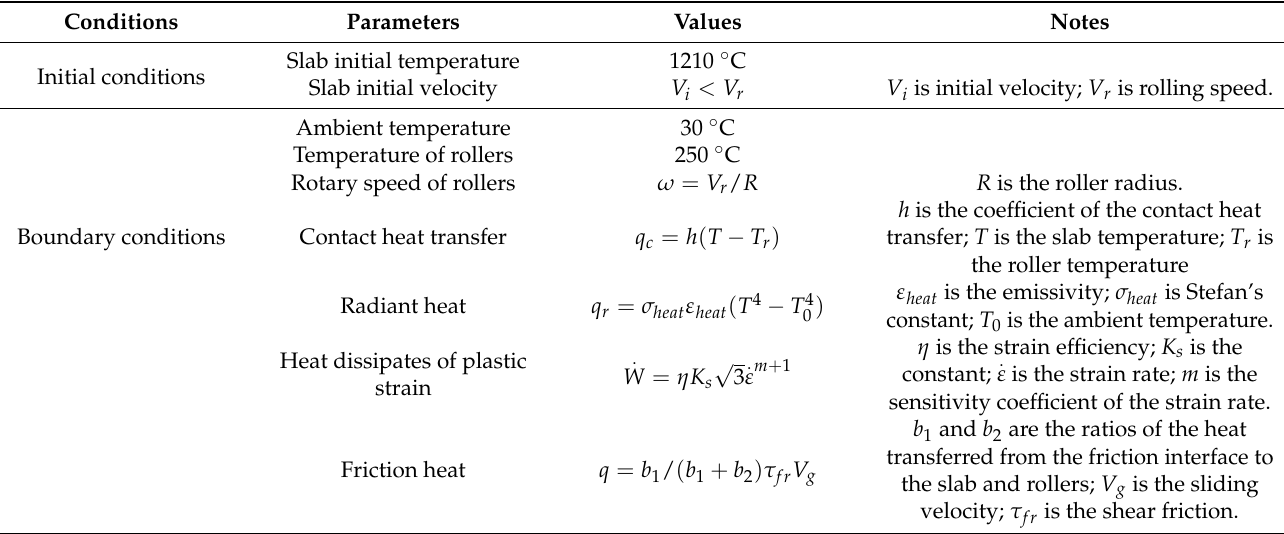
Table 3. The initial and boundary conditions for the